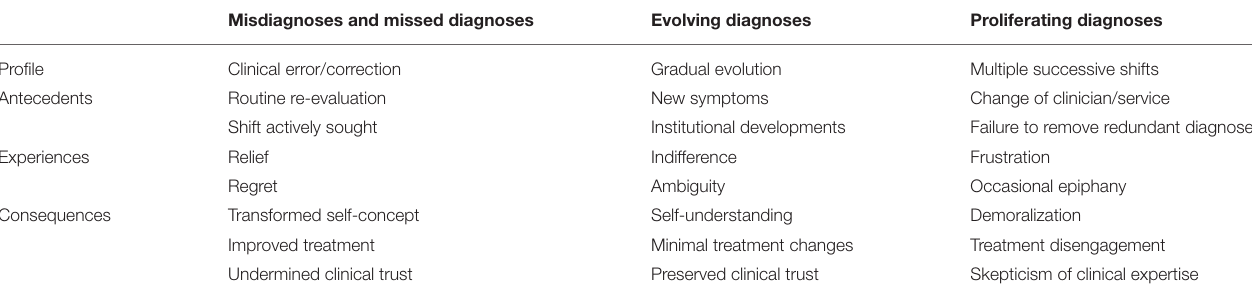
TABLE 1 | Interpretations of diagnostic shifts : typical narrative elements across the three types of